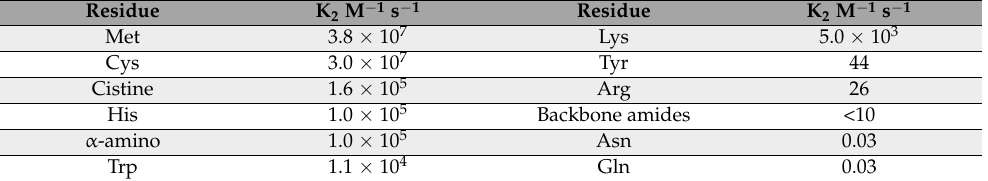
Table 1. Second-order rate constant for backbone amides varies over several orders of magnitude, depending on the environment. This value is a maxima estimate based on studies with cyclic dipeptides.